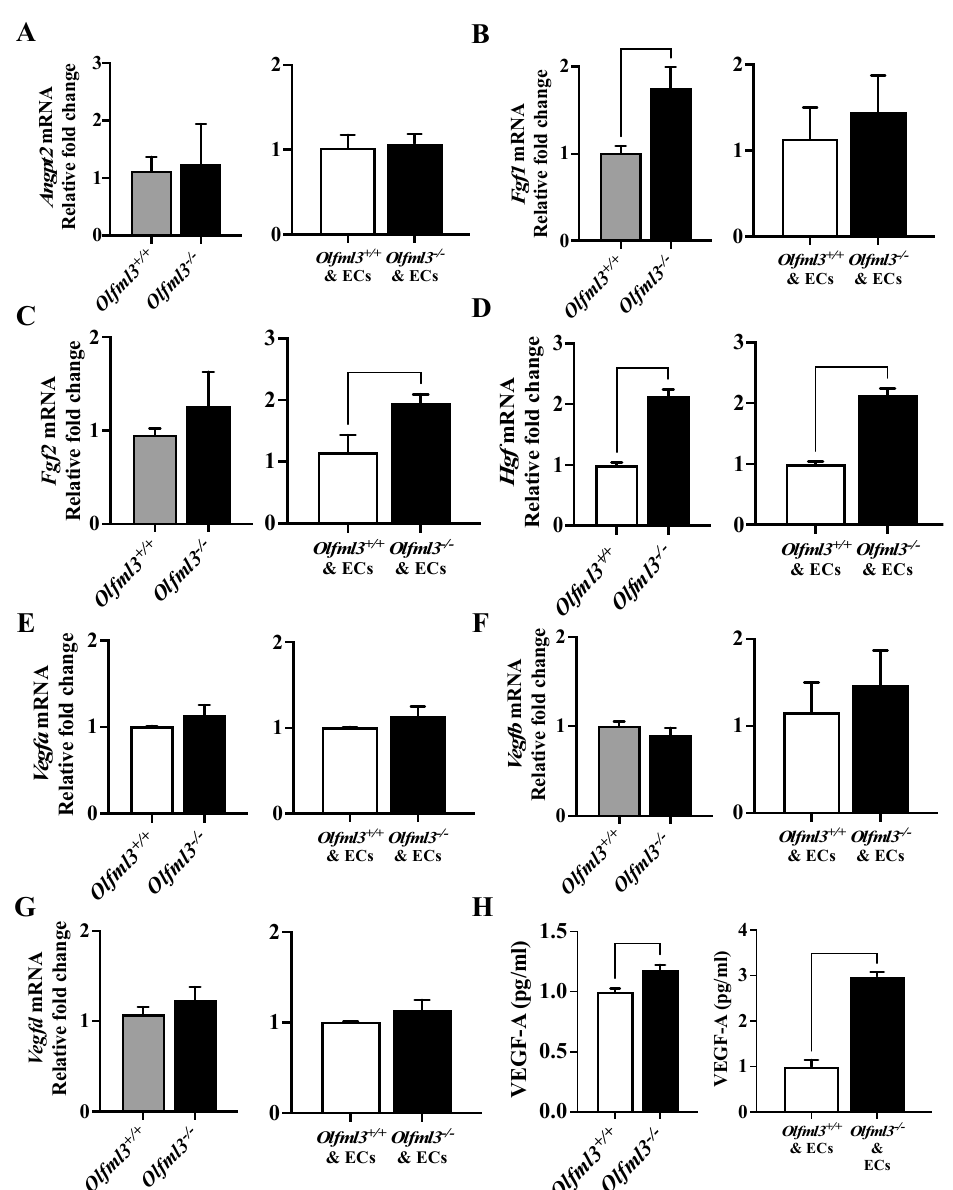
Figure 4. Loss of microglial Olfml3 increased expression of alternate microglia-derived pro-angiogenic factors. ( A ) mRNA levels of Angpt2 were not affected by loss of microglial Olfml3 when cultured alone ( p = 0.8582) or in the presence of ECs (48 h; p = 0.7947). ( B ) Fgf1 mRNA was increased in Olfml3 − / − microglia cultured alone ( p = 0.0243) but not in the presence of ECs ( p = 0.5997). ( C ) Fgf2 mRNA levels were not affected by loss of Olfml3 in microglia cultured alone ( p = 0.5139) but were moderately increased in the presence of ECs ( p = 0.0407). ( D ) Hgf mRNA increased in Olfml3 − / − microglia cultured alone ( p = 0.0143) and in the presence of ECs. Notably, mRNA levels of VEGF family genes ( E ) Vegfa , ( F ) Vegfb , and ( G ) Vegfd were unchanged in Olfml3 − / − microglia cultured alone or in the presence of ECs. ( H ) VEGF-A concentration, expressed as relative to isogenic control, in microglial supernatant was increased in Olfml3 − / − microglia cultured alone and in the presence of ECs. Comparisons based on unpaired student’s t test; bars represent group mean with standard error of the mean